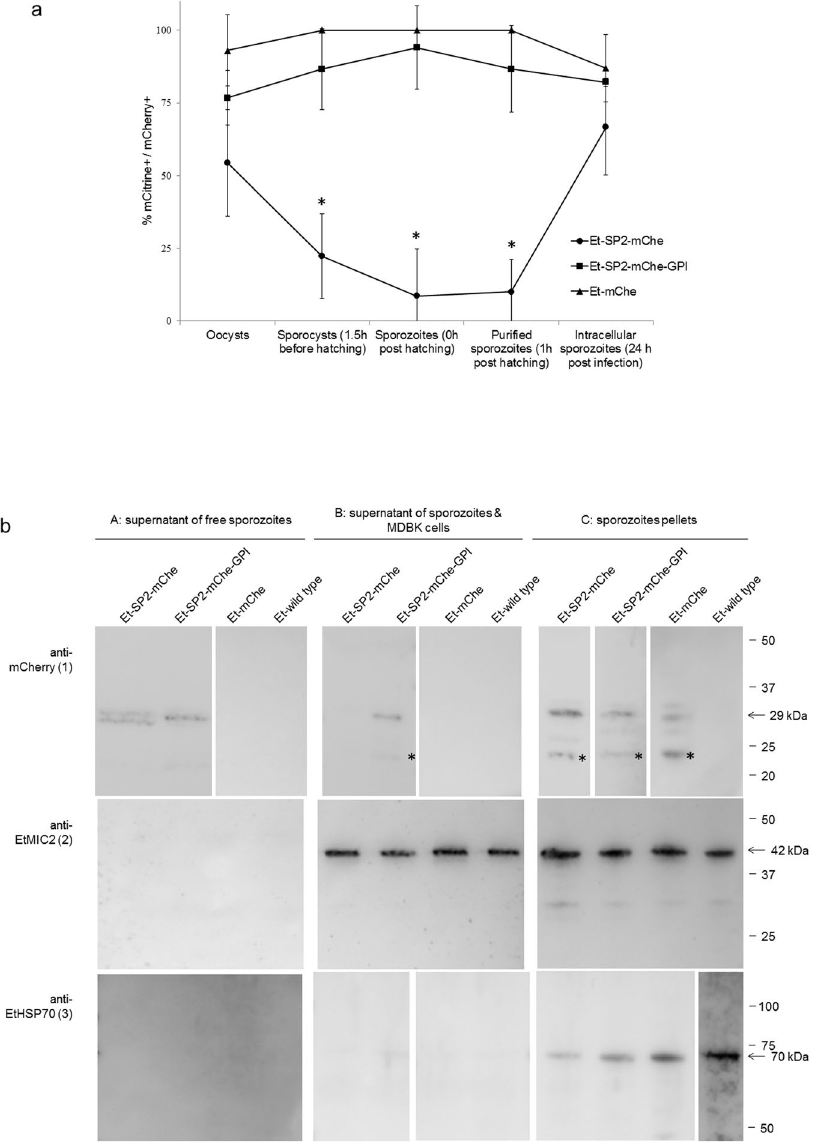
Figure 3. Analysis of the secretion/release of mCherry. ( a ) Proportion of double positive (mCitrine + / mCherry + ) parasites at different stages of sporozoite excystation and host cell invasion. * Indicate significant differences (p < 0.05, one-way ANOVA with post hoc Bonferroni test). ( b ) Western blot analysis of sporozoites supernatants. A: supernatants of free hatched sporozoites incubated in Advanced DMEM for 30 min at 41 °C – 5% CO 2 . B: supernatants of sporozoites incubated with MDBK cells in Advanced DMEM for 1 h at 41 °C – 5%CO 2 . C: sporozoites pellets (positive controls of expression). (1) anti-mChe antibody: mCherry was detected with the expected size in the supernatants of free sporozoites (A) of E t-SP2-mChe and supernatant of free sporozoites (A) and incubated with MDBK cells (B) of E t-SP2-mChe-GPI. mCherry was detected in the sporozoites pellets (C) of all the transgenic populations ( E t-SP2-mChe, E t-SP2-mChe-GPI and Et-mChe) but not in the wild type, as expected. A smaller unspecific band ( * ) was found in the positive samples. (2) anti- EtMIC2 antibody: endogenous EtMIC2 was detected in all the supernatants of sporozoites incubated with MDBK cells (B) and all the sporozoites pellets (C), confirming the induction of secretion of microneme proteins in the presence of the host cell. (3) anti-EtHSP70 antibody: EtHSP70 was only detected in the sporozoite pellets (C), confirming that parasites had not lysed and released their contents into the supernatants. Full length blots are presented in Supplementary Fig.